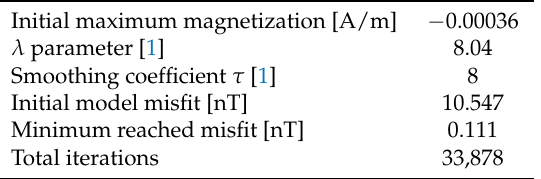
Table 9. Configuration of the magnetic inversion parameters for the salt